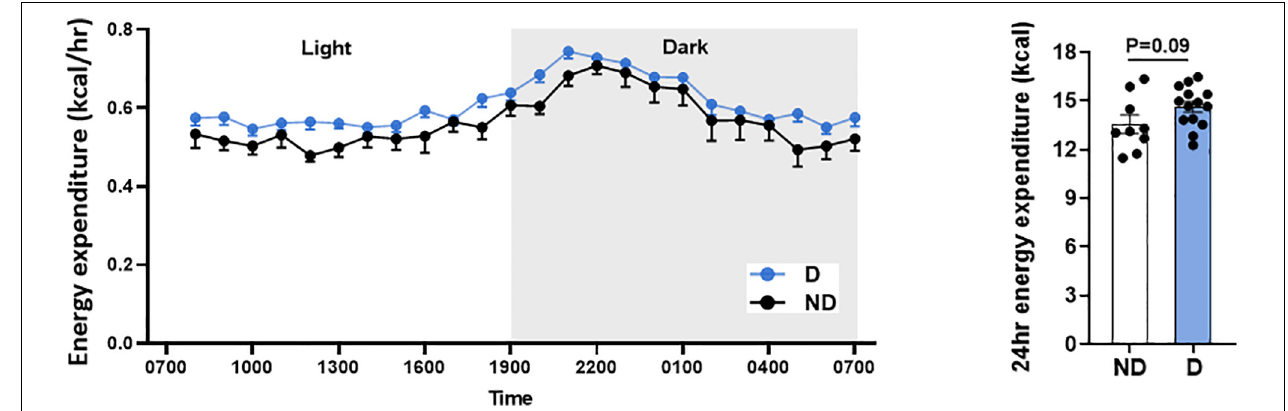
FIGURE 3 | Energy expenditure over 24 h in diabetic mice. Data represented as mean ± SEM. n = 9–14 per group (note individual data points). Data analysis used unpaired t -test. ND, non-diabetic; D, diabetes.